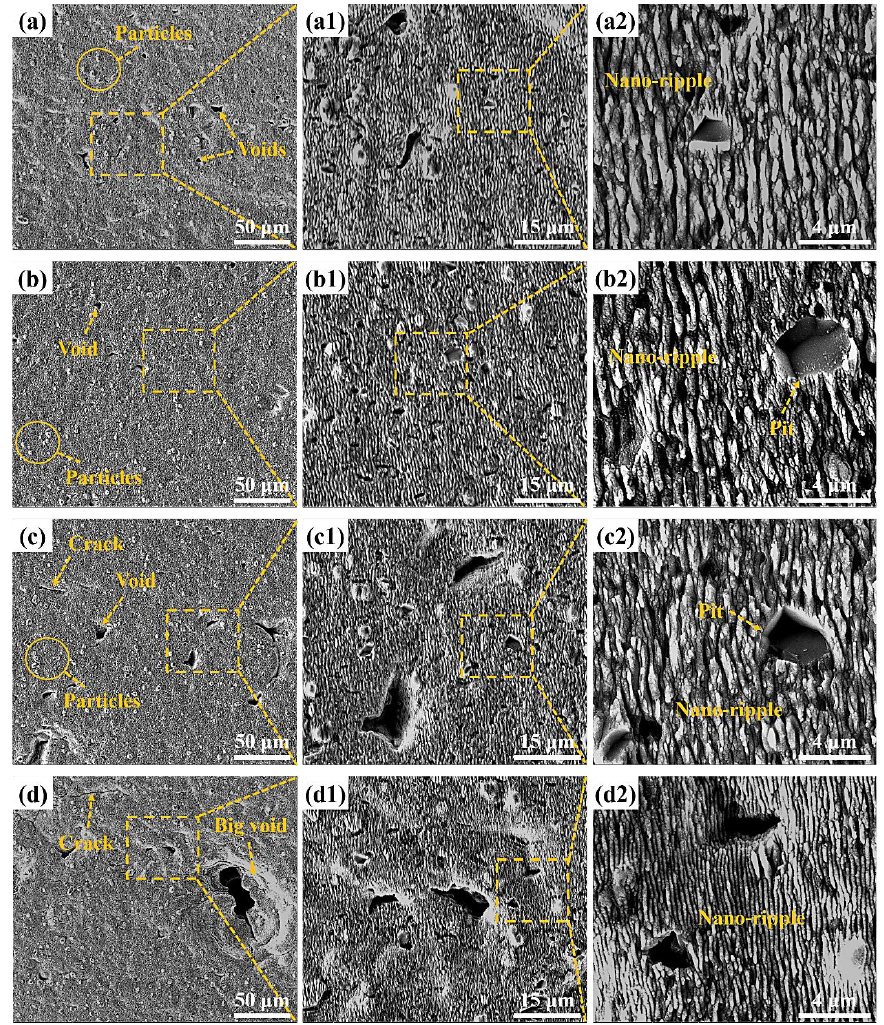
Figure 15. Polished surface morphologies and local magnifications under different defocus amounts. ( a ) − 1 mm, ( b ) 0 mm, ( c ) 2 mm, ( d ) 3 mm. The insets ( a1 ), ( b1 ), ( c1 ) and ( d1 ) were the partial enlarged details of the insets ( a ), ( b ), ( c ) and ( d ), respectively. The insets ( a2 ), ( b2 ), ( c2 ) and ( d2 ) were the partial enlarged details of the insets ( a1 ), ( b1 ), ( c1 ) and ( d1 ),